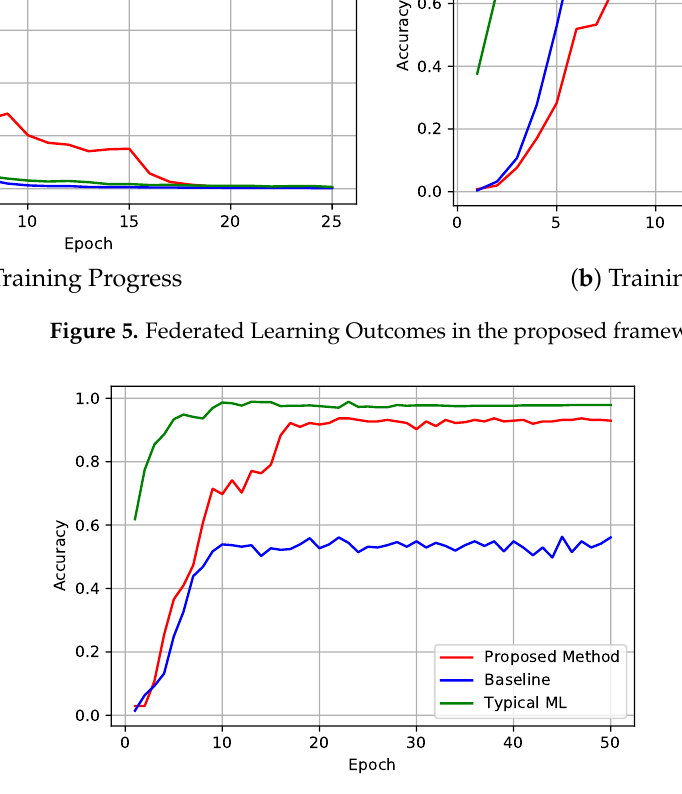
Figure 6. Validation Accuracy.